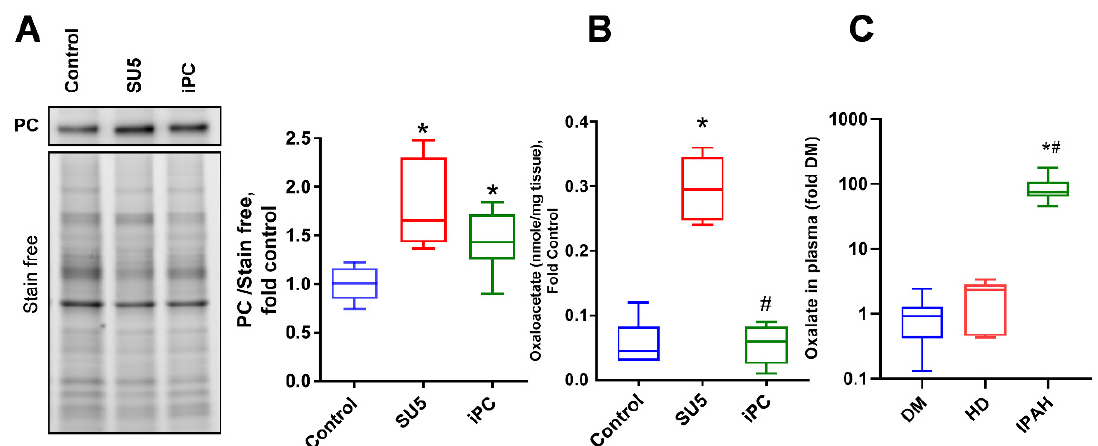
Figure 6. PC inhibitor controlled oxaloacetate (OAA) production in PAH. ( A ) Pyruvate carboxylase expression and its product. ( B ) Oxaloacetate was significantly increased in the PAH model. ( C ) Increased oxalate plasma concentration was identified in idiopathic PAH (IPAH) patients compared to diabetes mellitus (DM) or left heart disease (HD) patients. Data expressed as box-and-whisker plot with median value ± min max, N = 5–6, * p < 0.05 versus control or DM, # p < 0.05 versus SU5 or HD by ANOVA.